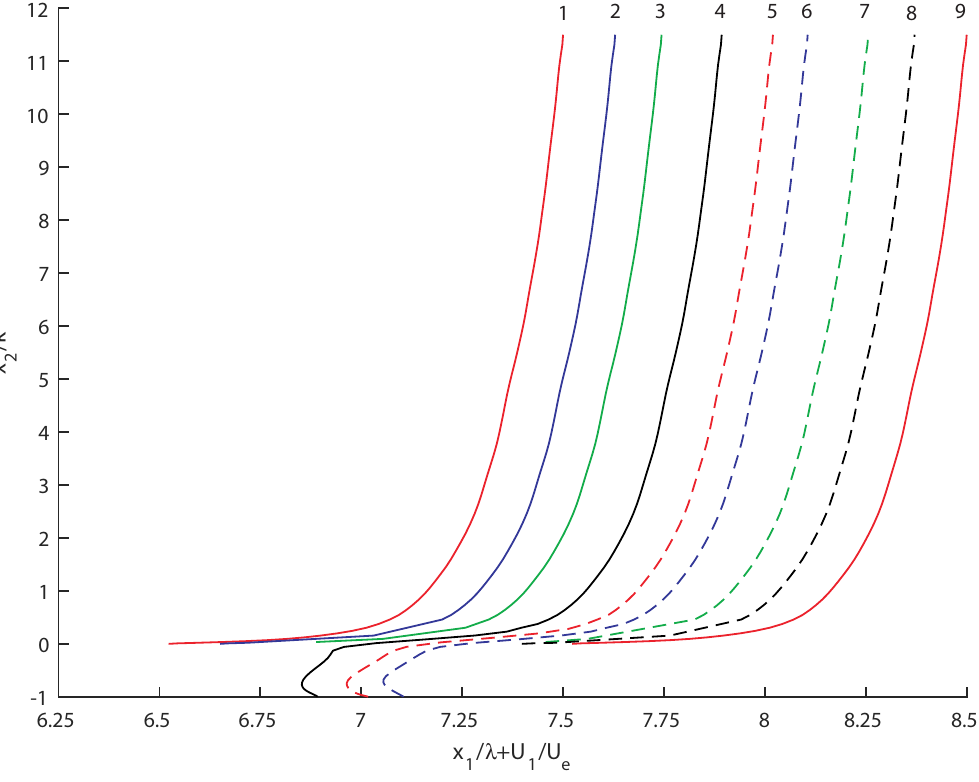
Figure 3. Vertical profiles (1, 2, ..., 9) of predicted mean-flow velocities U 1 for Run 1 at nine locations within a pitch ( λ ) from the 7th bar (middle) to the 8th bar (middle). The longitudinal coordinates are x 1 / λ equal to 6.5, 6.629, 6.744, 6.893, 7.02, 7.106, 7.256, 7.371, and 7.5, respectively. The average of the velocities at the water surface ( x 2 / k = 11.5) is taken as the freestream velocity U e . The nine locations are in the channel center plane ( x 3 = 0.0375 m).